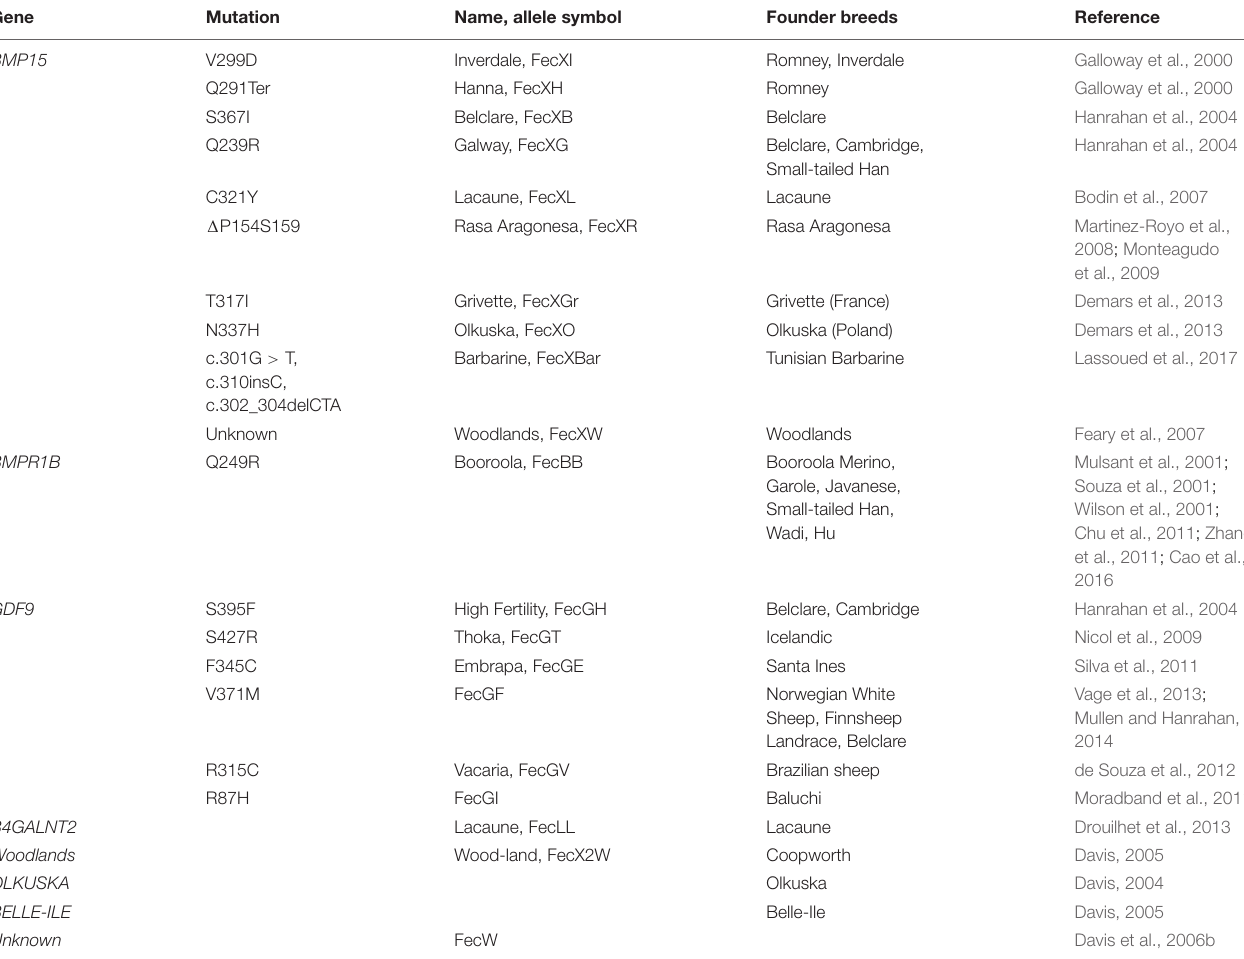
TABLE 1 | Genetics variants associated with the fecundity in sheep.